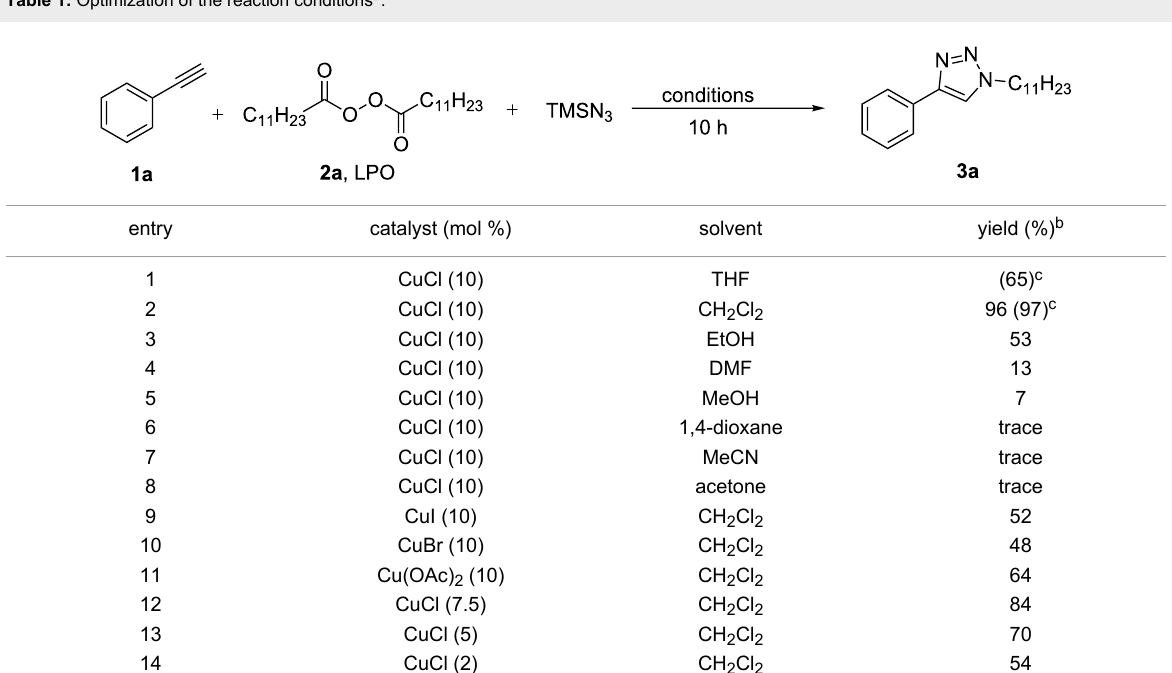
Table 1: Optimization of the reaction conditions a